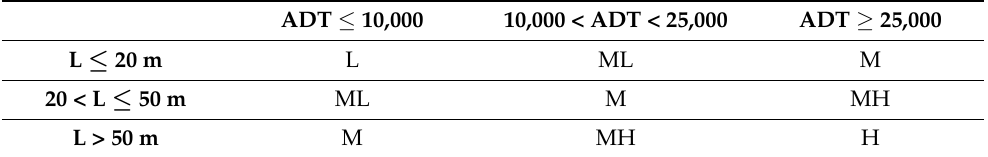
Table 4. Primary exposure classification based on the Average Daily Traffic (ADT) and the average span length